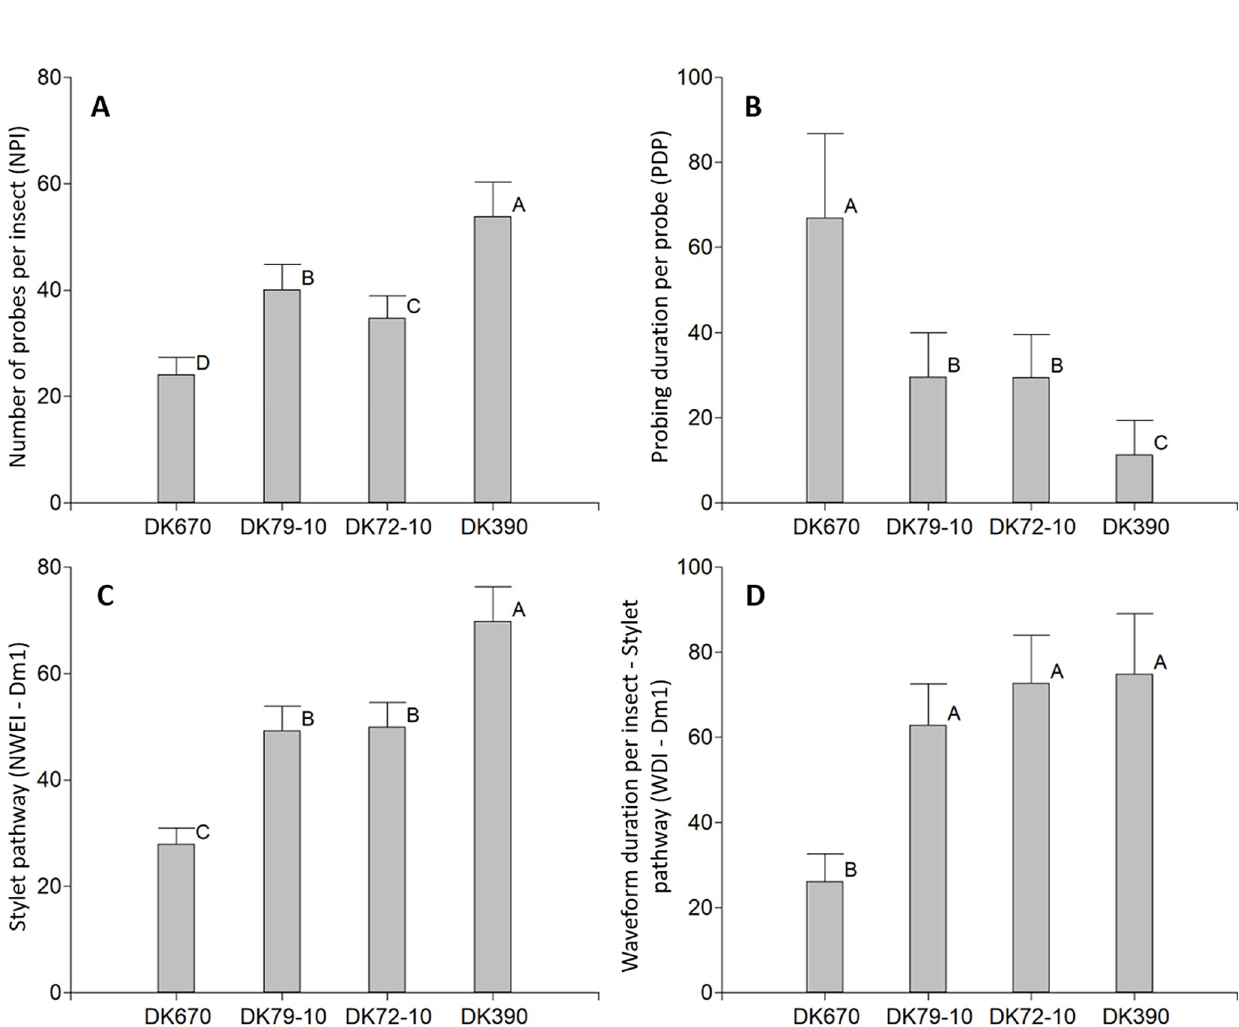
Fig 3. Variables of probing behavior of D . maidis with access to four maize hybrids, non-phloem phase. A: Number of probes per insect (NPI), B: Probing duration per probe (PDP), C: Number of waveform events per insect—Stylet pathway (NWEI—Dm1), D: Waveform duration per insect—Stylet pathway (WDI—Dm1). Values with the same letter are not significantly different according to contrasts in the Fisher LSD test ( α = 0.05). Bars indicate standard error of the mean.